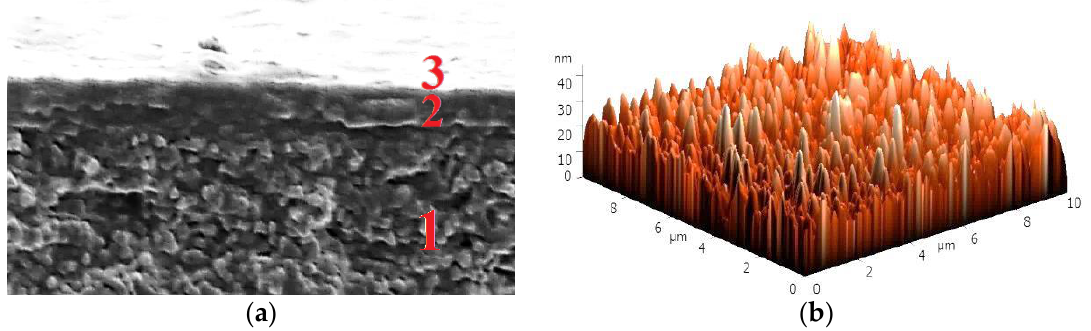
Figure 8. ( a ) A cross-sectional SEM micrograph and ( b ) a surface AFM image of the SA-5HF/PAN CaCl2 -5Lbl PSS/SA membrane after the pervaporation dehydration of isopropanol (12–70 wt.%